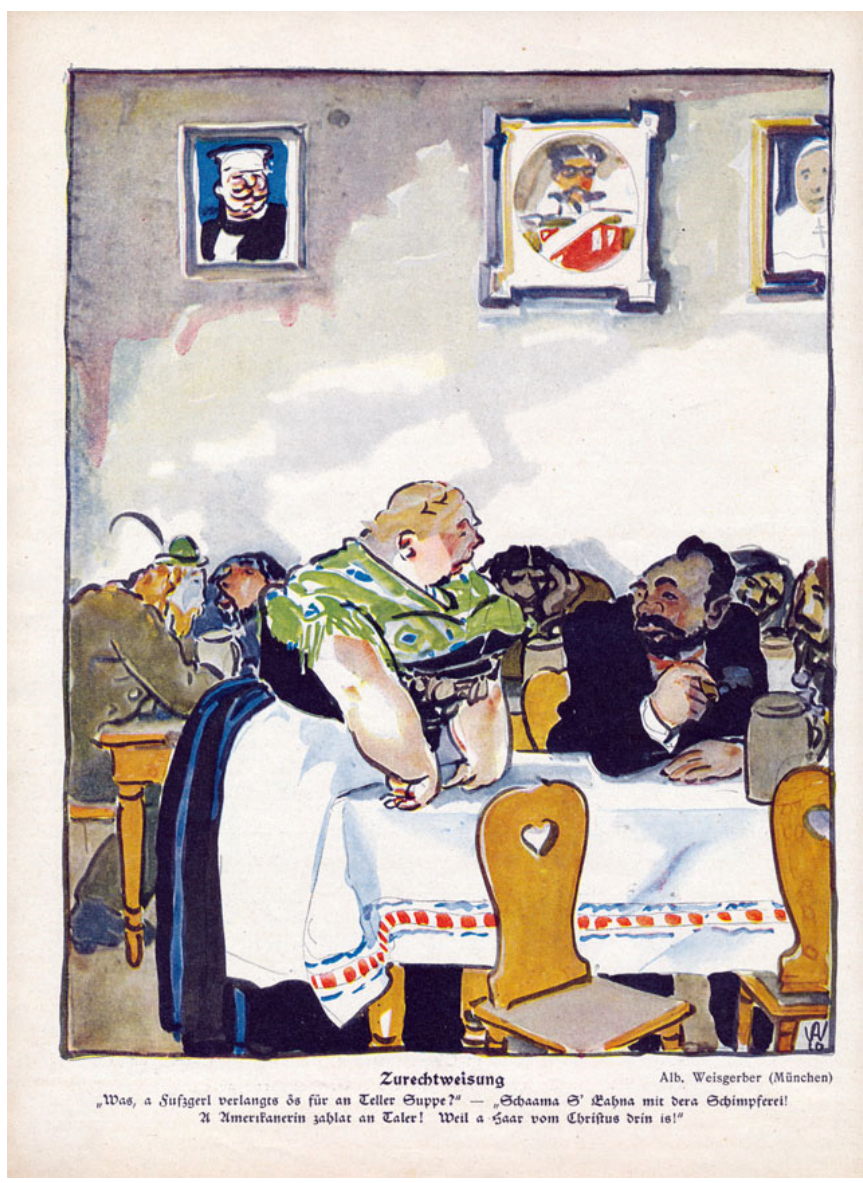
Figure 2. Jugend 26 (1910), p. 606.